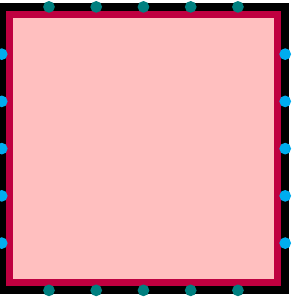
Figure 5. Structure of the used FEM model. On the bottom and top are the dual-use EIT elec- trodes/radar antennas. On the right and left are pure EIT electrodes. The skin is colored in purple. The rest of the breast is modeled with fat, which is represented by the pink-colored areas. The size of the model is 100 mm 100 mm. This is the same as in Prati et al. ×